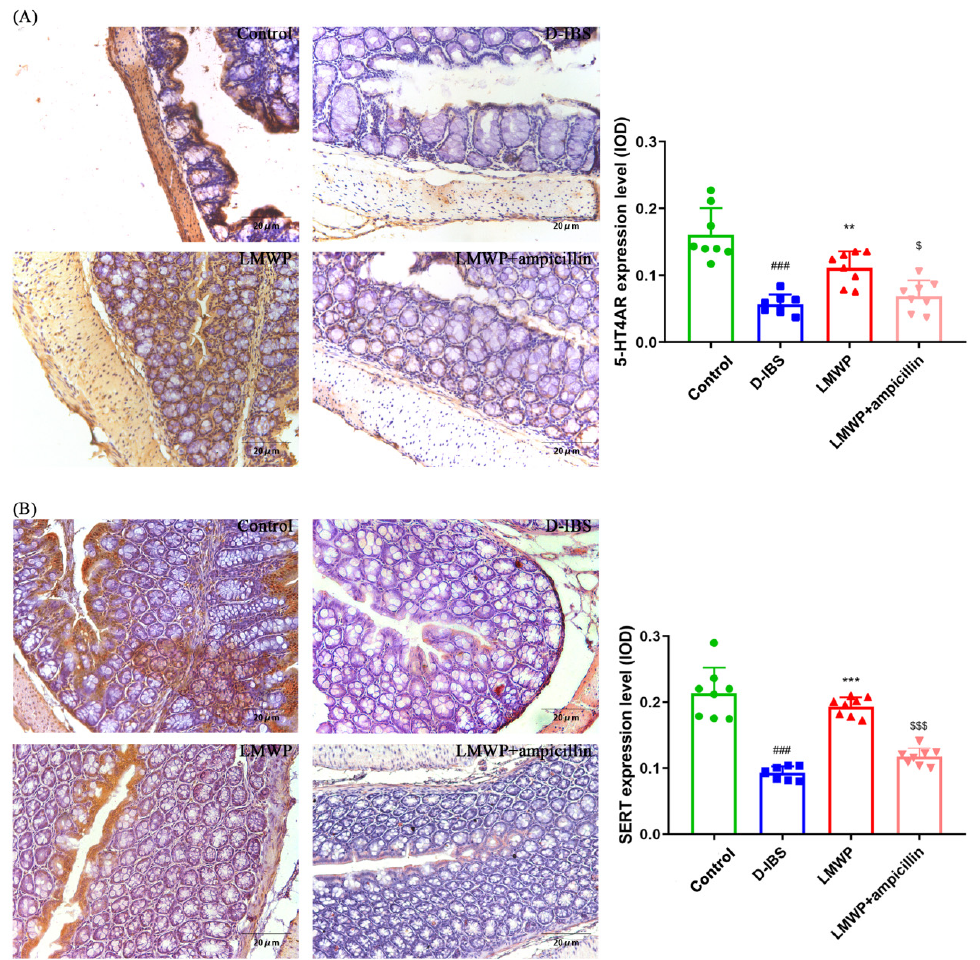
Figure 6. Immunohistochemical staining in the colon. ( A , B ) 5-HT4R and SERT. Values are presented as the means ± SD ( n = 8). ### p < 0.001 compared to Control, ** p < 0.01 compared to D-IBS, *** p < 0.001 compared to D-IBS, $ p < 0.05 compared to LMWP (S3-3) from the larvae of Musca domestica and $$$ p < 0.001 compared to LMWP (S3-3) from the larvae of Musca domestica .